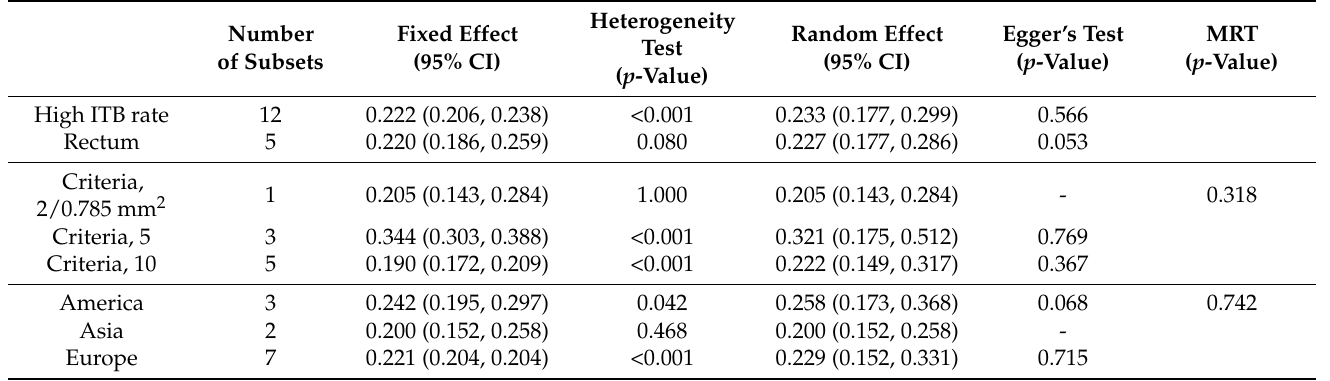
Table 2. The estimated rates of intratumoral budding in colorectal